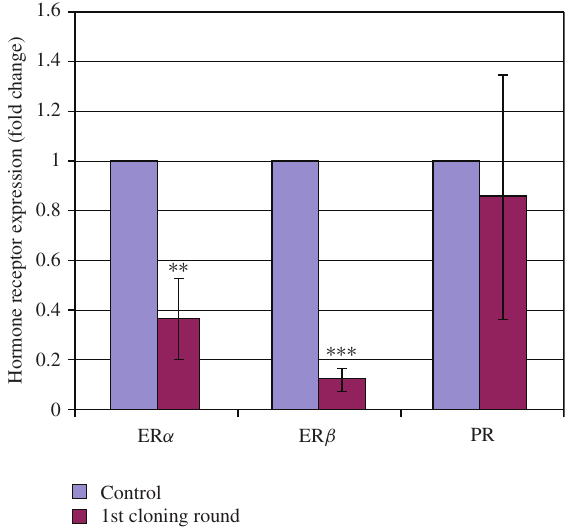
FIGURE 2: Fold change of hormone receptor expression in endometrial stroma cell cultures after the first cloning round. Error bars = SEM, n = 11 , ∗∗ = P < 0 . 01 , ∗∗∗ = P < 0 . 001